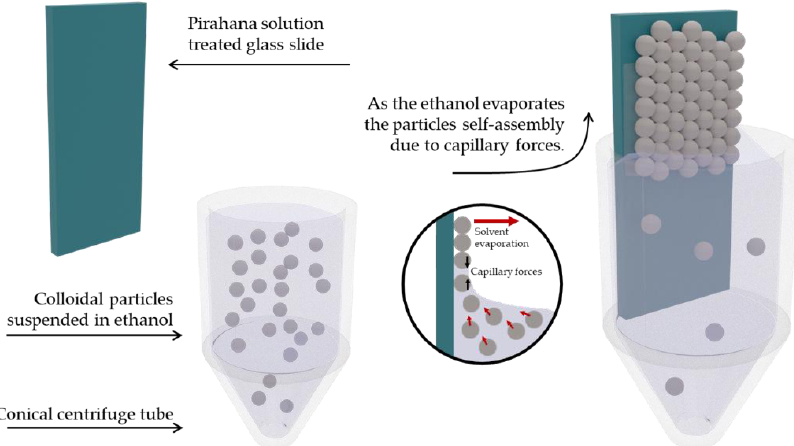
Figure 1. Setting to obtain organized an opalescent array of SiPs. The particles were fully suspended in ethanol at different concentrations, within a conical bottom centrifuge tube. The conical bottom was necessary to avoid a drastic thickening of the arrays at the bottom of the slide. A piranha solution treated glass slide is carefully placed vertically in the tube. The system is placed in a quiet, vibration free environment, where the ethanol evaporates at constant rate. The suspended particles self-assemble on the glass due to capillary forces in an organized manner as the evaporation takes places.